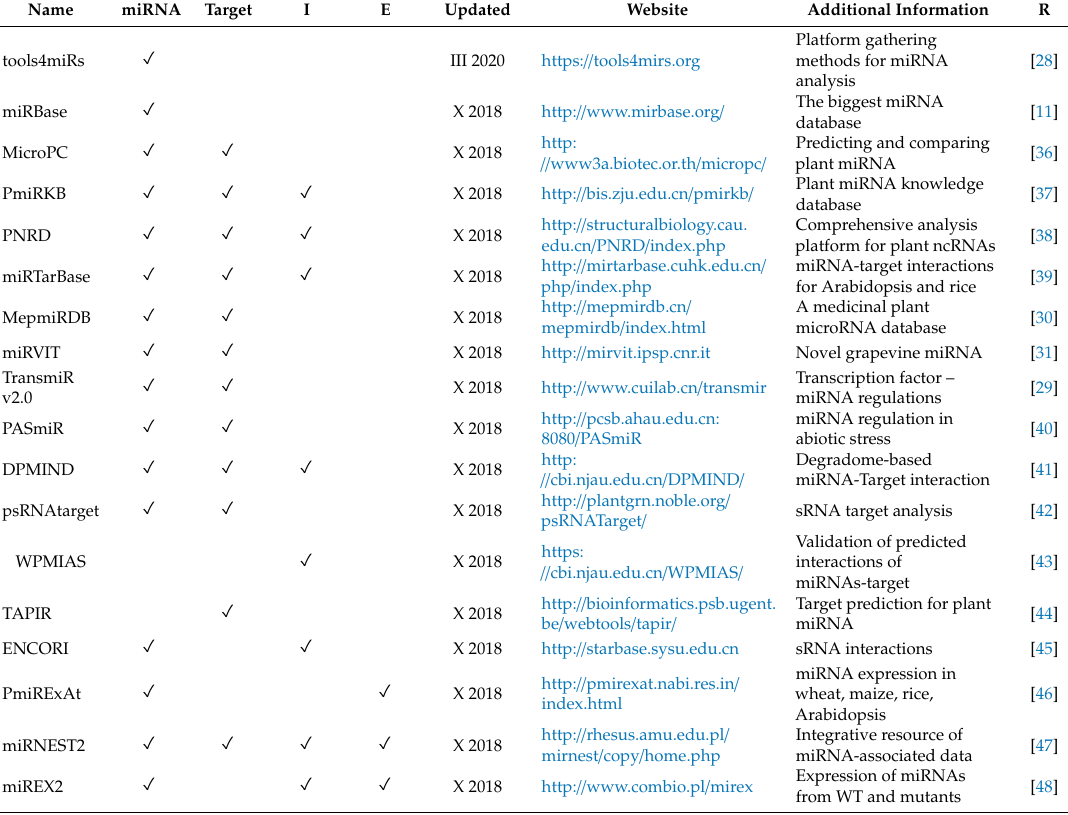
Table 1. The publicly available plant miRNA databases and web tools for in silico analyses [8,48,50 – 52,58 – 70]. WT: Wild type; R: References; E: Expression; I: Interaction.